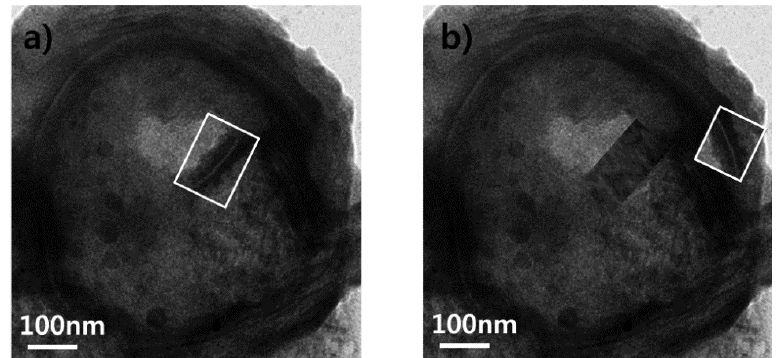
Figure 9. Staining lipid shell microbubble and the shell structure. Negative-stained TEM images with uranyl acetate and phosphotungstic acid was used to visualize the shell layer. The electron acceleration voltage was increased up to 120 kV to puncture the shell and to stain inside if possible. A fragment of the shell shown in Figure 9a was relocated to the shell surface to create Figure 9b. The fragment seems to fit the missing surface portion and form a complete shell surface. In other words, fragments of the shell do not seem to reform after being separated from the microbubbles. Figure 9c shows the bilayer-like structure of a fragment with a shell thickness of approximately 7